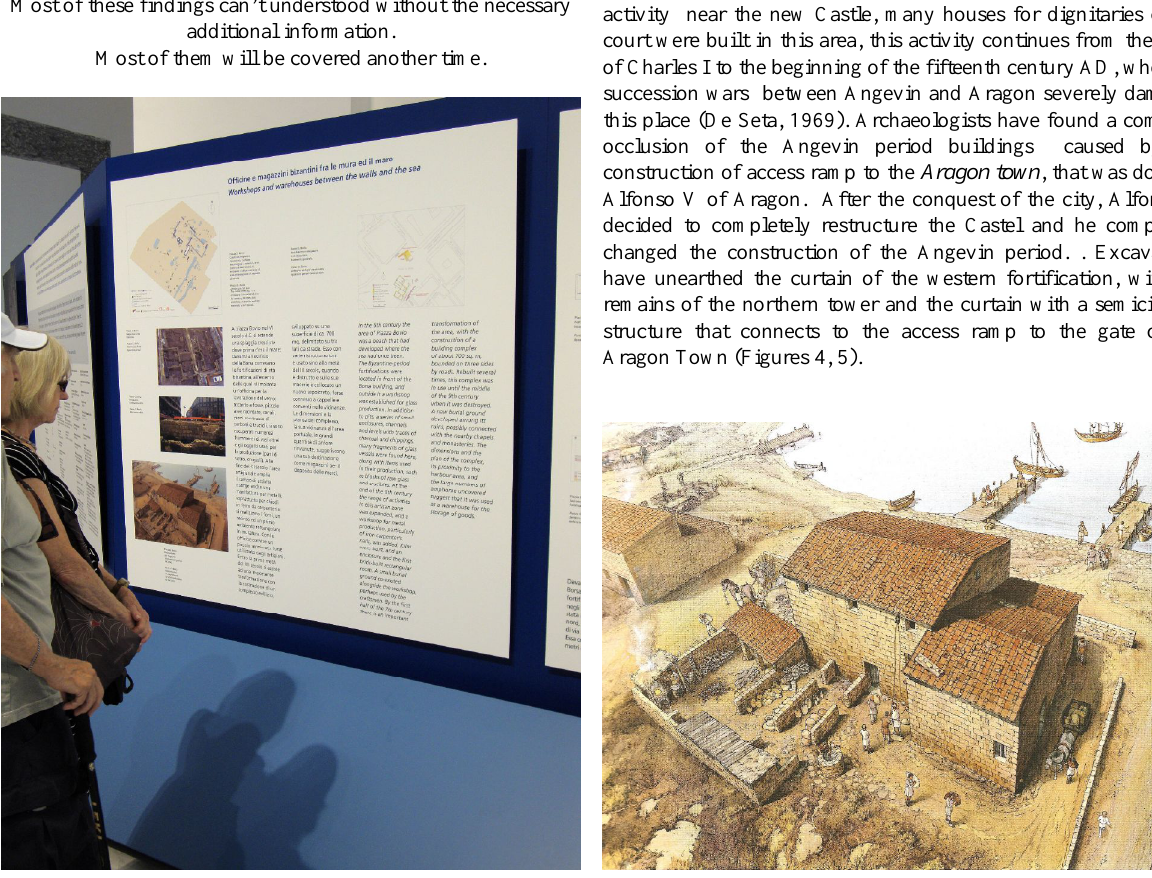
Figure 11: Ancient Naples cost line, graphic elaboration by INKLINK. This kind of reconstruction it isn't enough to understand the story of the